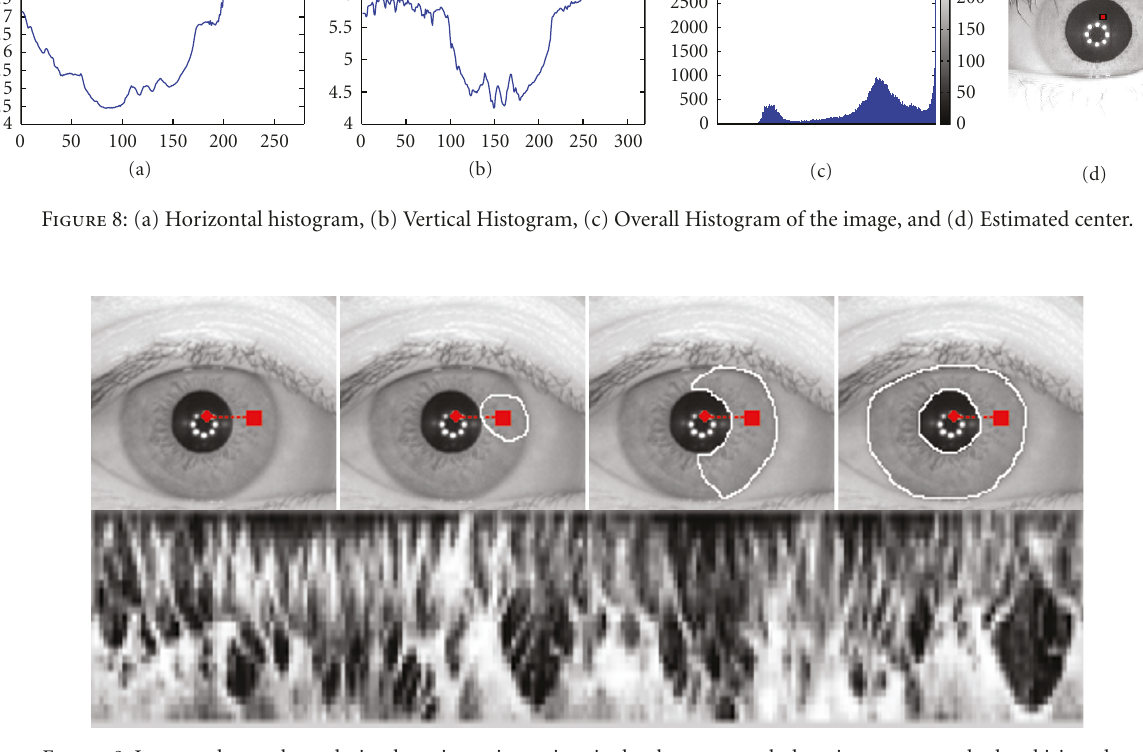
Figure 9: Inner and outer boundaries detection using pointwise level set approach done in one step and related iris